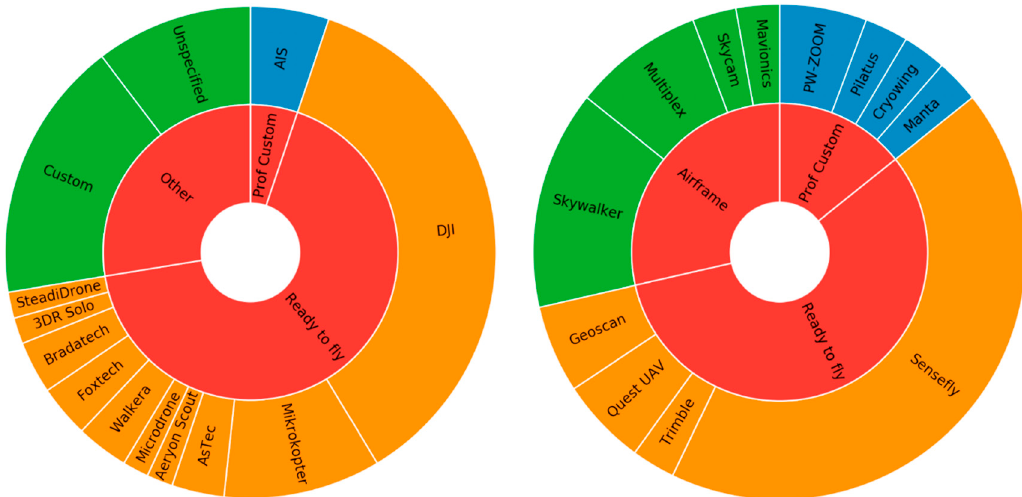
Figure 4. The preferred brands of multirotor (left) and fixed-wing (right) vehicles used among the surveyed studies. Inner circles of each categorize the chosen platforms as ready to fly/off the shelf UAVs, if they were an airframe that requires some customization, or professionally customized UAVs. Note multirotor “AIS” is an abbreviation for Aerial Imaging Solutions. Multirotor category “Custom” includes studies that explicitly said they flew a customized multirotor. The sample size for multirotor and fixed wing brands was 58 and 35 respectively.